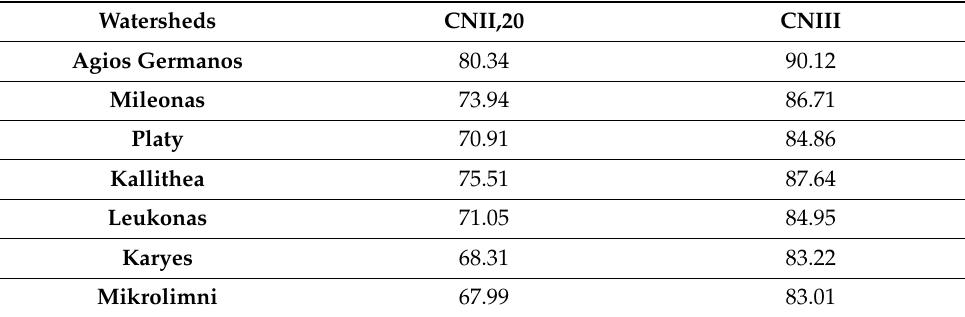
Table 8. CNII,20 and CNIII mean value for all the watersheds.